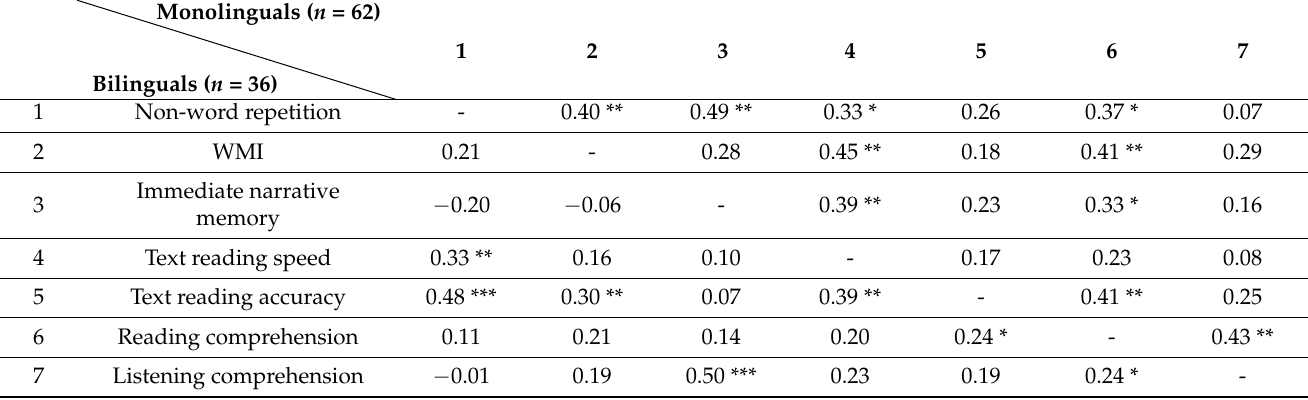
Table 2. Correlations between variables for monolinguals and